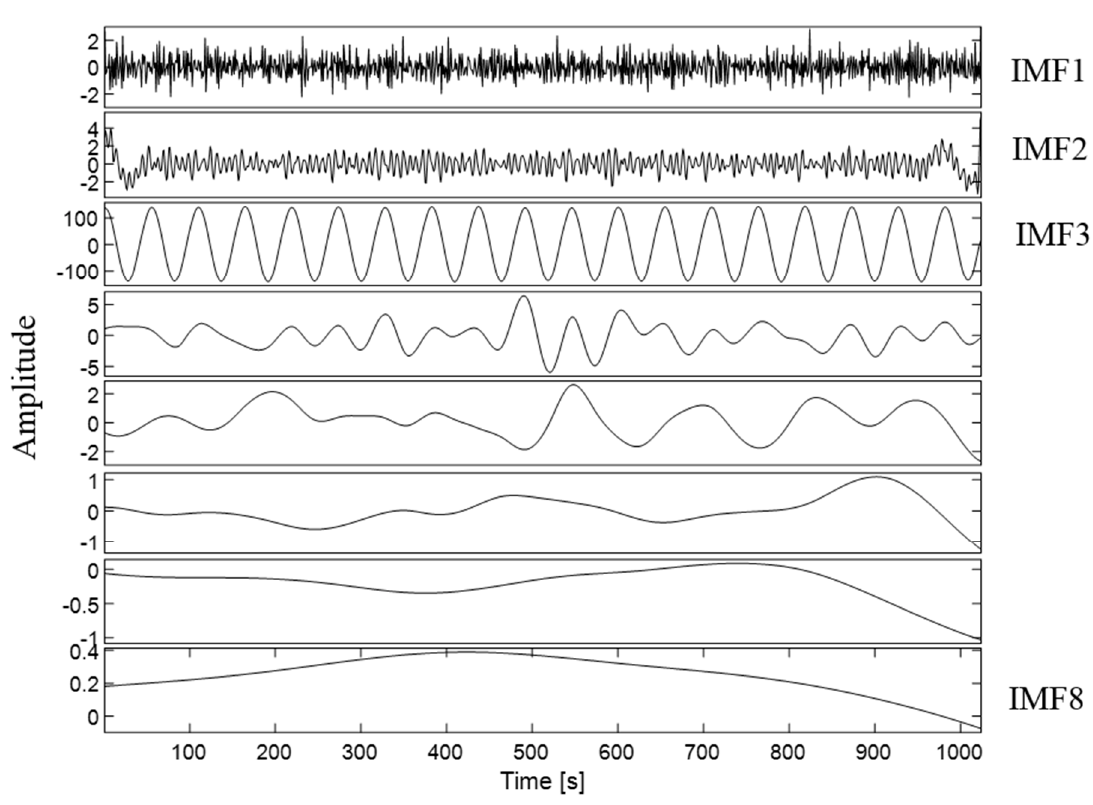
Figure 25. Decomposition results of the displacement signal by EEMD.